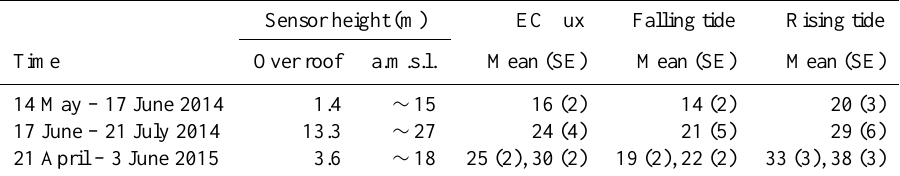
Table 1. Summary of sampling periods, mast height above observatory rooftop and above mean sea level (a.m.s.l.), and hourly eddy co- variance CH 4 fluxes (µmolem − 2 d − 1 ) for the south-west wind sector (180–240 ◦ ). CH 4 fluxes when the sampling height was 15ma.m.s.l. are likely to be underestimates of air–sea transfer because a significant portion of the flux footprint was over land (Sect. 3). For the last period (2015), fluxes are computed from both the Windmaster Pro and R3 sonic anemometer (shown in that order). SE indicates standard